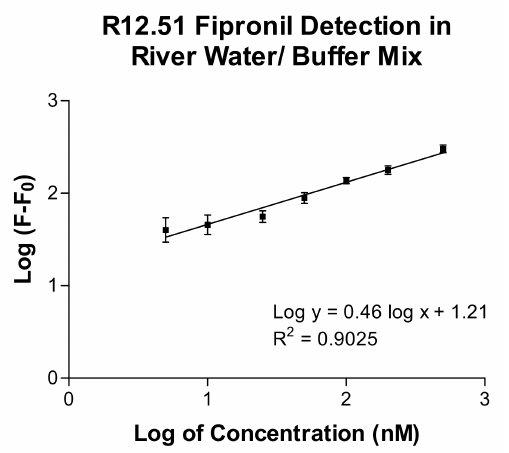
Figure 5. The calibration curve of fluorescence intensity with increasing concentrations of fipronil spiked in river water/buffer mix. Data is transformed by logarithmic scale. Normalized average fluorescence from triplicate samples are presented. F 0 and F are values of normalized fluorescence intensities without and with fipronil. Buffer: 1 × selection buffer. Error bars are representative of ± 1 × standard